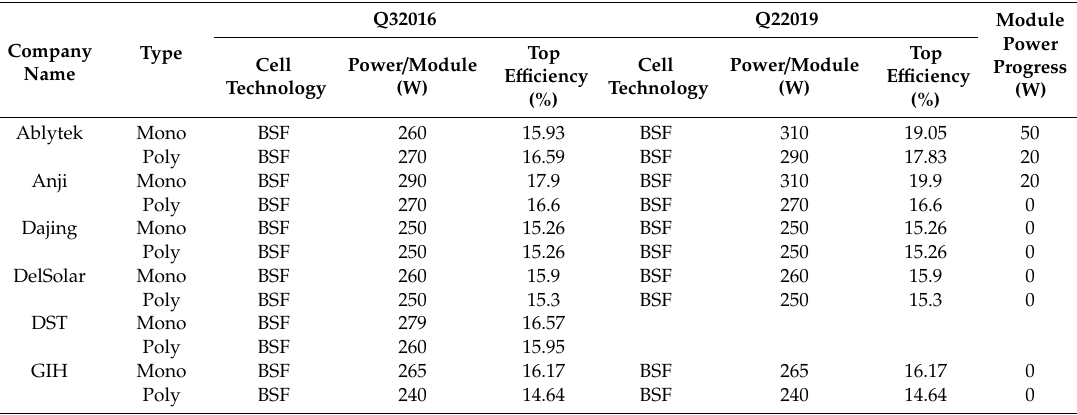
Table A2. c-Si module product output over the period